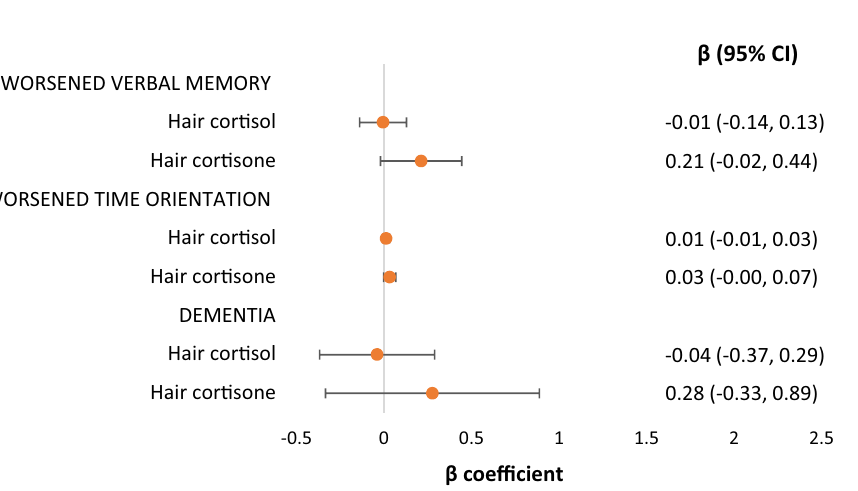
Figure 1. Associations of hair cortisol and cortisone and cognitive function and dementia in fully adjusted